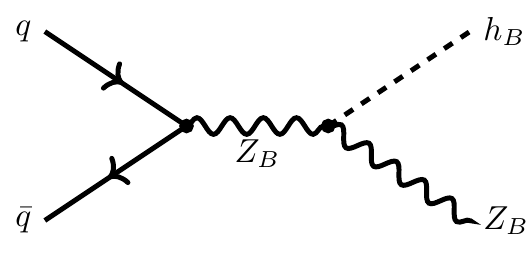
Figure 7 . Feynman graph for the process ¯ qq → Z ∗